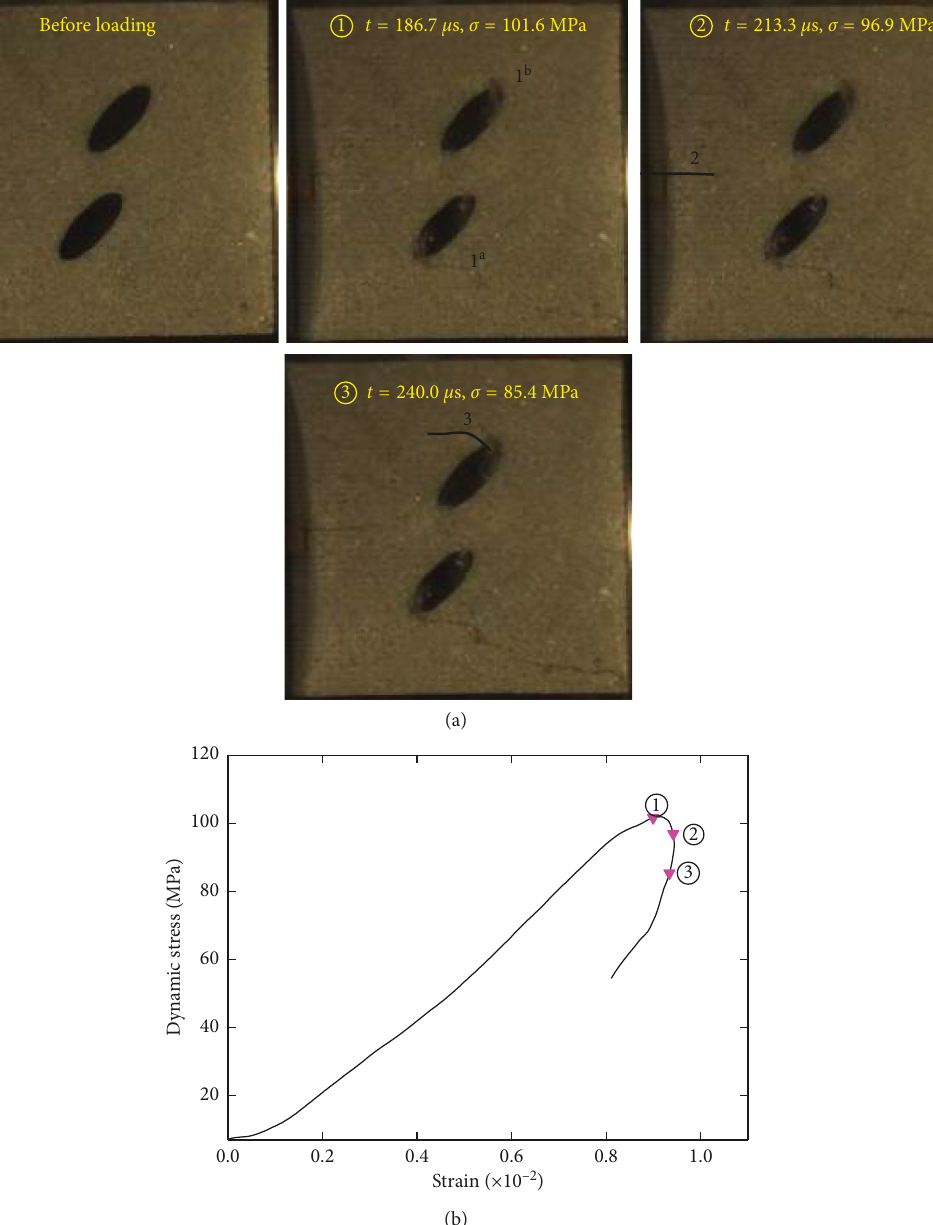
Figure 19: Fracturing process of type IV mode with its corresponding dynamic stress-strain curve ( α